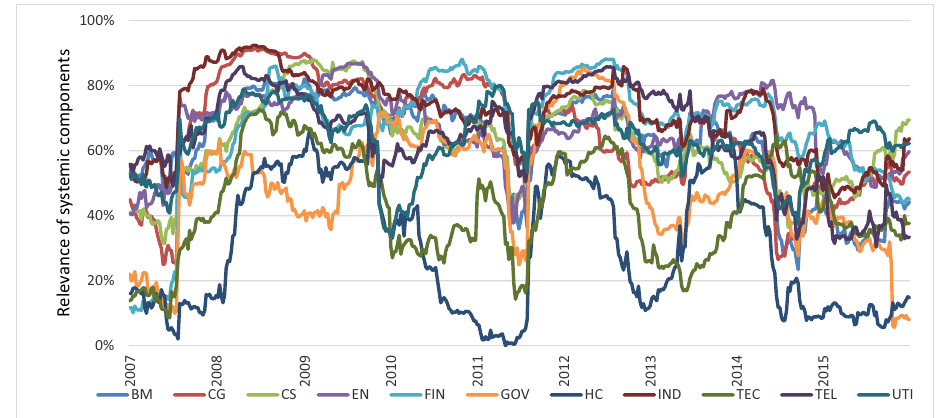
Figure 4. Relevance of systemic sectorial components. The figure shows the evolution over time of the relevance of the systemic component of risk in each sector, as a percentage of total credit risk. Weekly data: January 2007–December 2015. BM = Basic materials, CG = Consumer goods, CS = Consumer services, EN = Energy, FIN = Financials, GOV = Government, HC = Health care, IND = Industrials, TEC = Technology, TEL = Telecommunication services, and UTI =